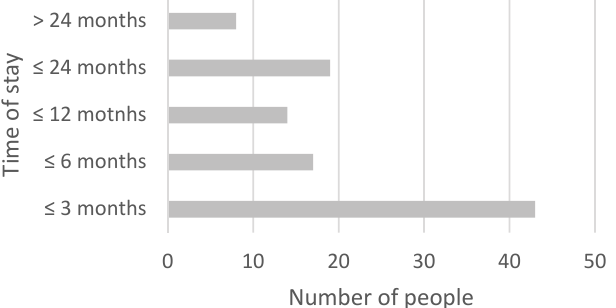
Figure A2. Time of stay at Simonsland, first survey (101 individuals).